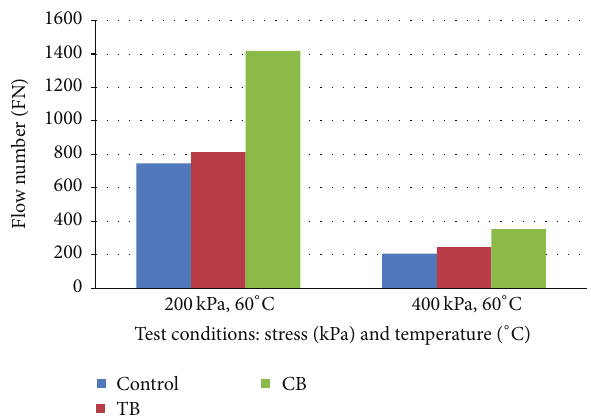
Figure 7: Flow number (FN) for control and rubberized asphalt mixtures at different stress levels tested at 60 ∘